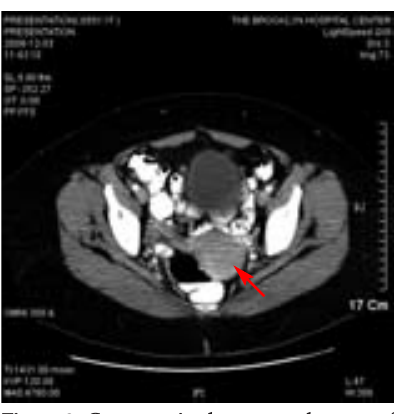
Figure 3. Computerized tomography scan of the pelvis showing soft tissue enhancement measuring 6x5.6 cm in the left wall of the vagina (arrow) consistent with metastatic clear cell carcinoma of the vagina.